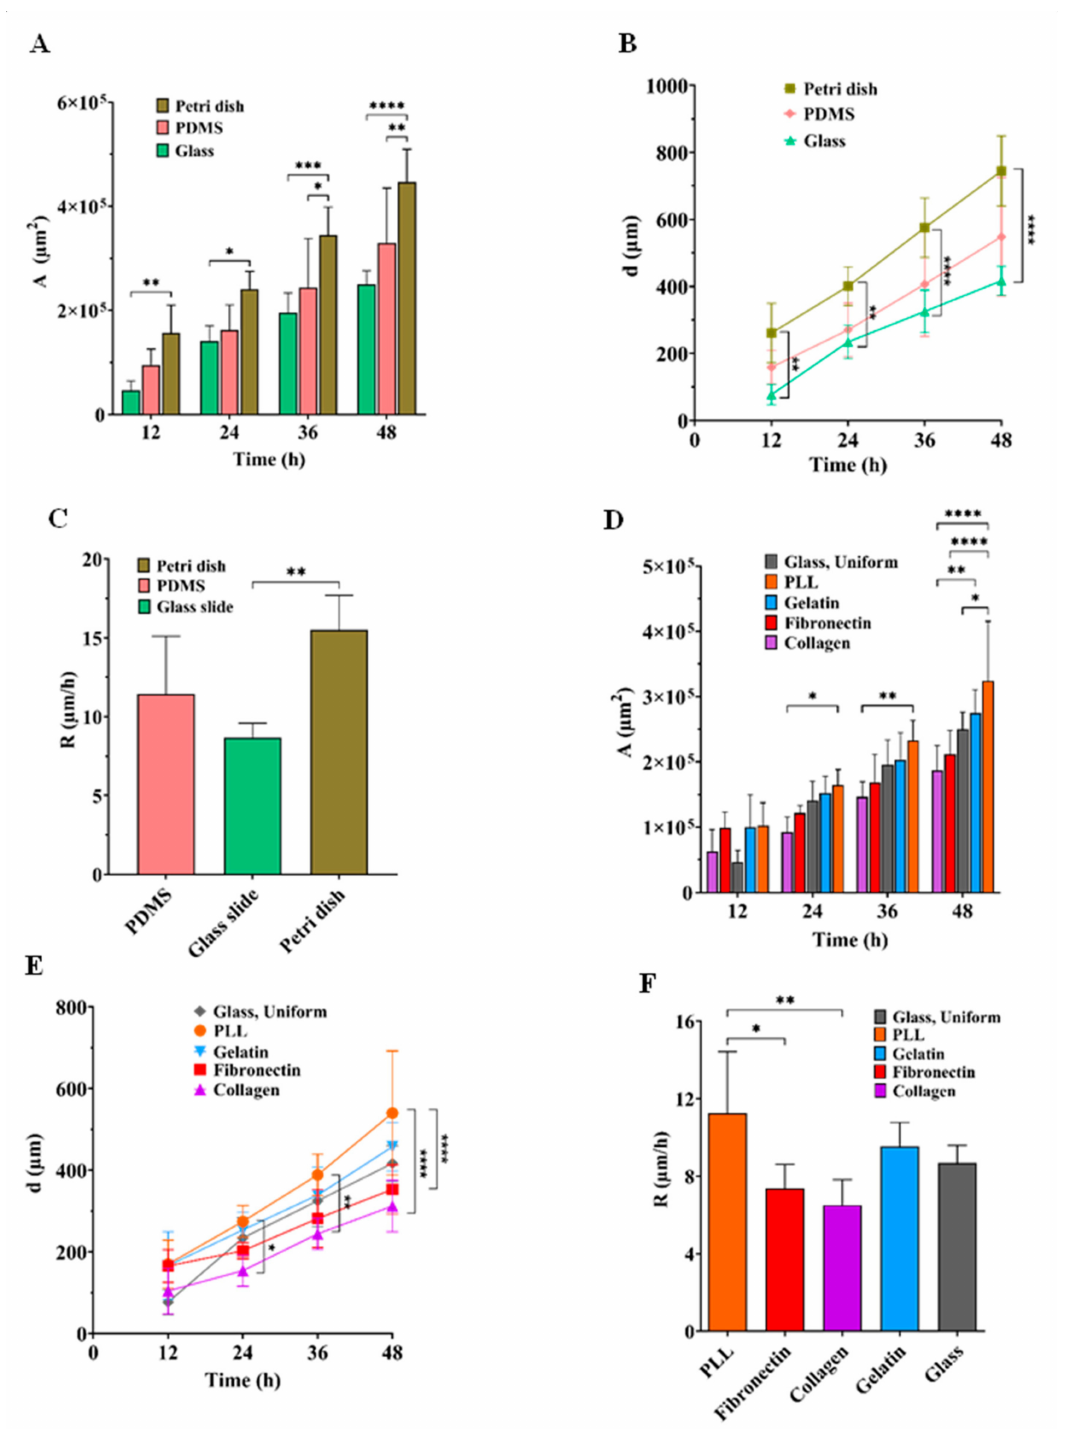
Figure 6. Quantification of cell migration on glass, polystyrene and PDMS substrates. ( A ) cell migration area and ( B ) distance substrates at 0 h, 12 h, 24 h, 36 h and 48 h after creating the cell-free area and ( C ) migration rate of the cells after 48 h. Quantification of cell migration on glass (control), PLL, fibronectin, collagen and gelatin-coated substrates. ( D ) cell migration area and ( E ) distance at 0 h, 12 h, 24 h, 36 h and 48 h after generating the cell-free area, and ( F ) migration rate of the cells after 48 h. Value was shown as mean ± SD. For each condition, five independent experiments were performed ( n = 5). *: p < 0.5, **: p < 0.01, ***: p < 0.0001 and ****: p <